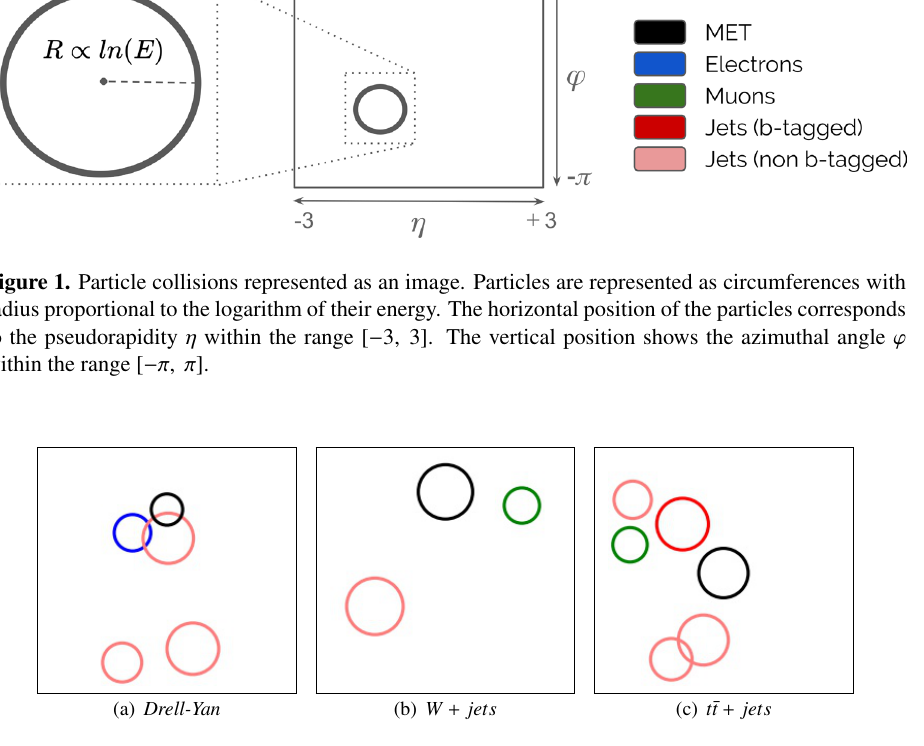
( t ¯ t + jets ) and background ( Drell-Yan and W + jets ) context, with 50 / 50 splits, the signal vs background discrimination e ffi ciency would be